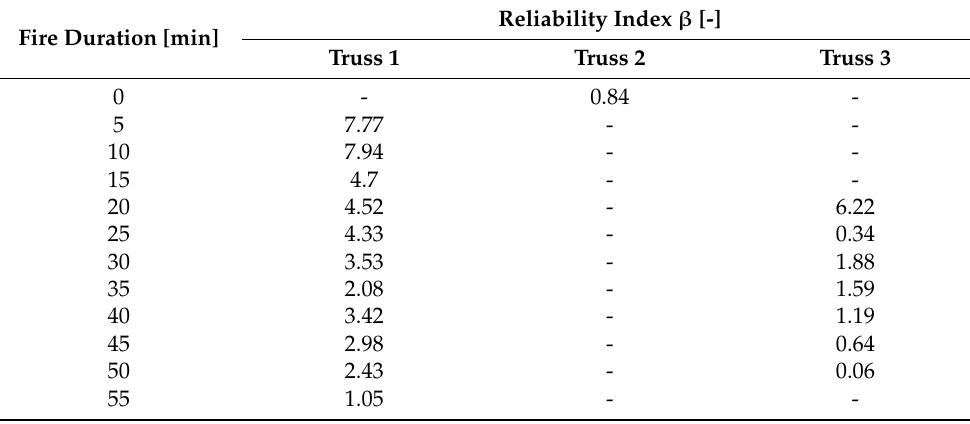
Table 5. The effect of action and load-bearing capacity for Truss 2 in the fifth minute of fire duration. No. of Element Effect of action [kN] Load bearing capacity [kN] Effect of action [kN] Load bearing capacity [kN] No. of Element Effect of action [kN] Load bearing capacity [kN] Table 6. Reliability indices for trusses 1, 2, 3 in the following minutes of fire duration. Fire Duration